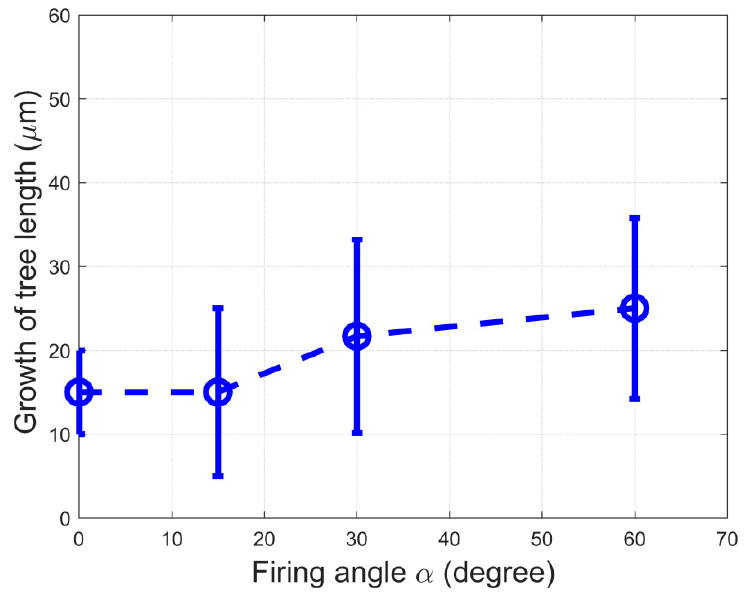
Figure 11. Growth of tree length against the firing delay angle at negative voltage.